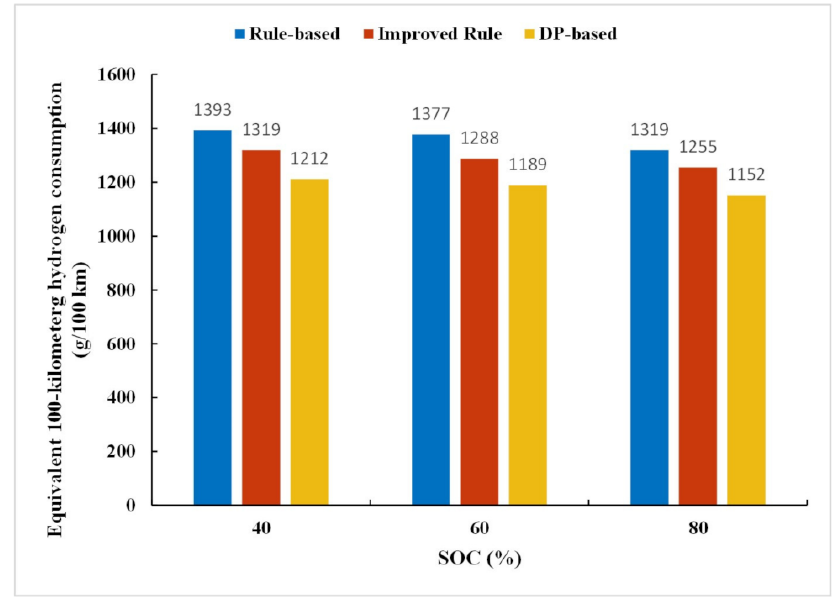
Figure 20. The equivalent 100 km hydrogen consumption under different initial SOC values.